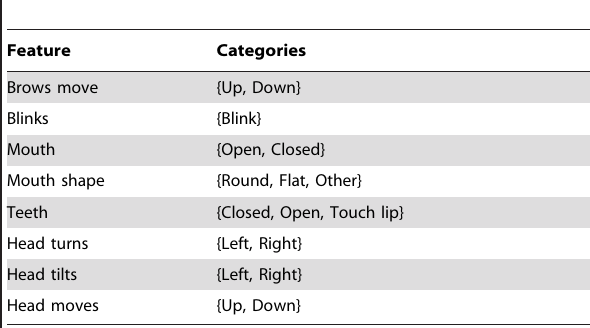
Table 1. Features of the model and their entry